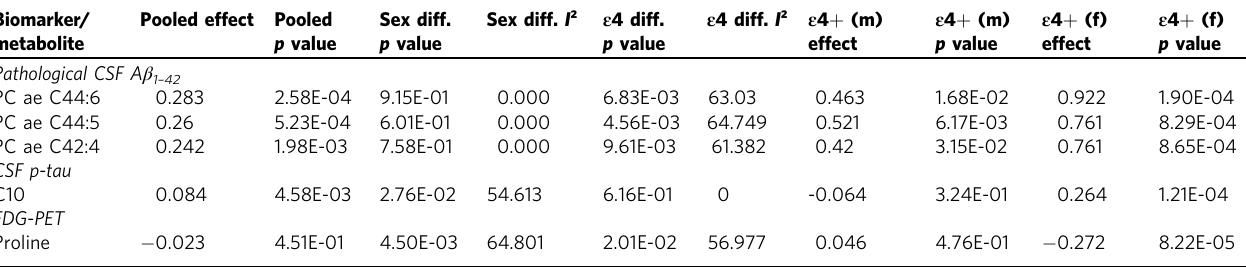
Table 4 Association results and heterogeneity estimates for metabolites in relation to A-T-N biomarkers in APOE ε 4 carriers strati fi ed by